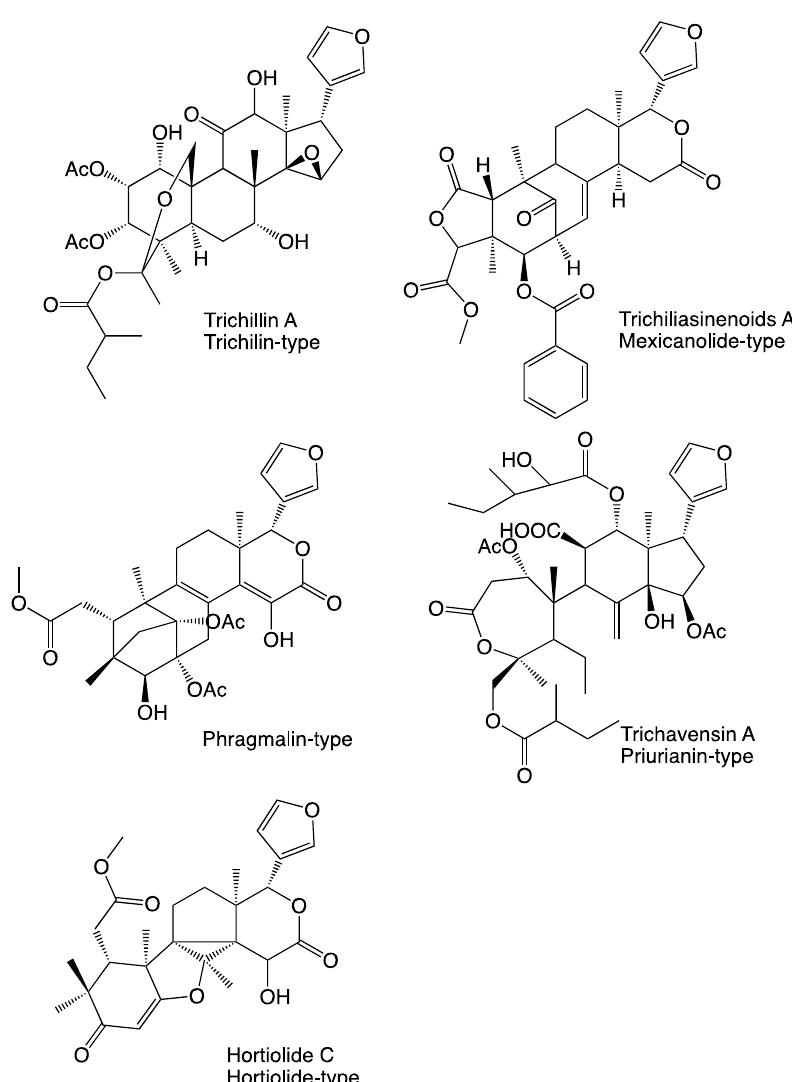
Figure 1. Related compounds isolated from other sources.